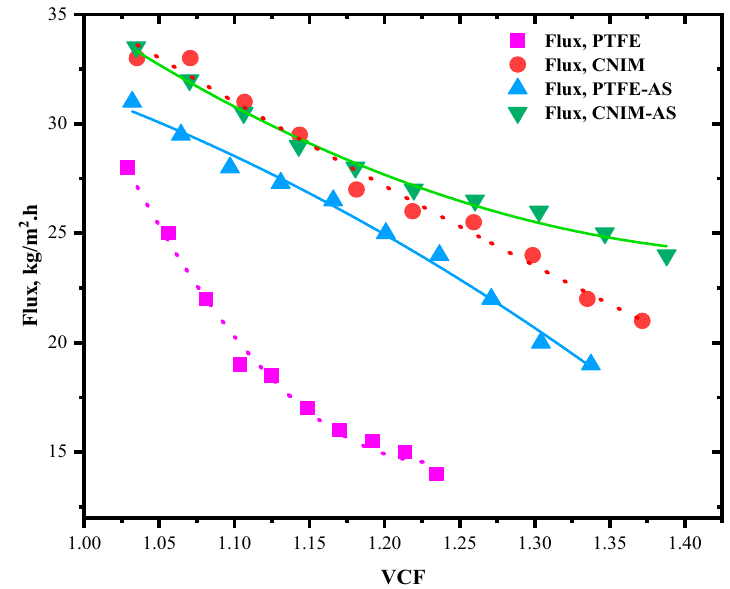
Figure 7. Variation of flux for various volumetric concentrating factor (VCF).